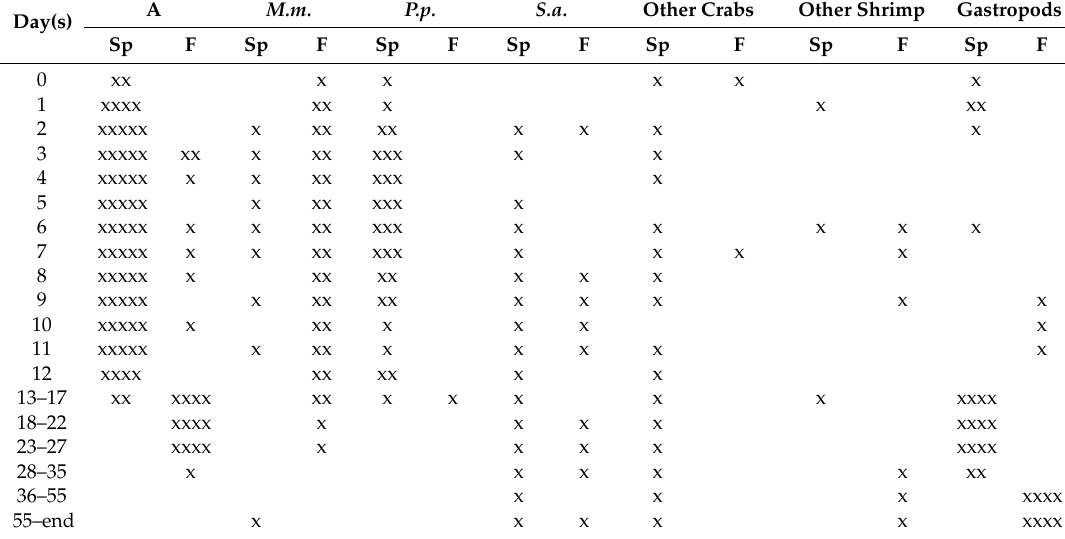
Table 1. Presence or absence of the major fauna on pig carcasses in spring and fall in Strait of Georgia at 170 m. F = fall, Sp = spring, A = amphipods, M.m. = Metacarcinus magister (Dana, 1852), P.p. = Pandalus platyceros Brandt, 1851, S.a. = Sebastolobus alascanus Bean, 1890. Relative abundance for most